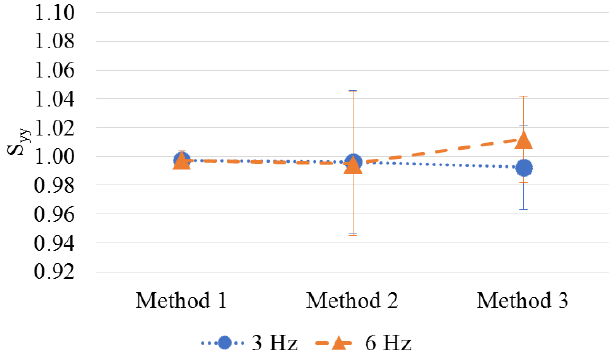
Figure 15. MEMS accelerometer: sensitivity matrix obtained by means of Method 3 (3-D diagram).